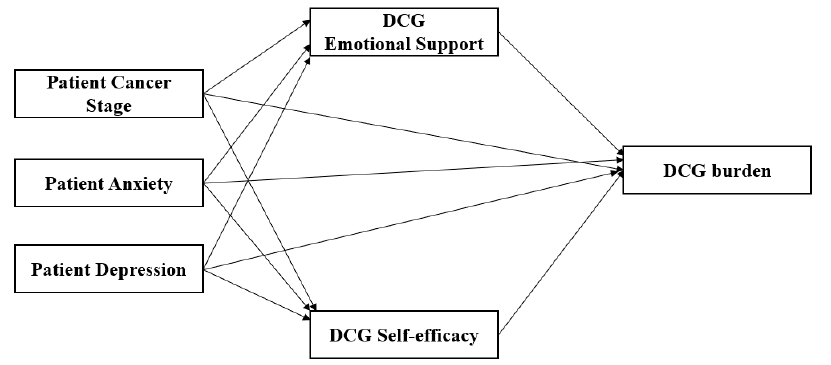
Figure 1. Study conceptual framework.